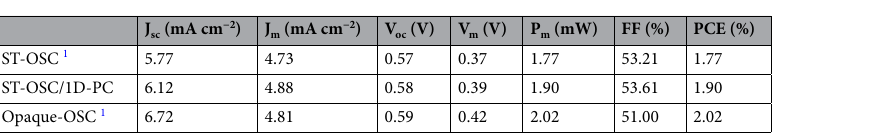
Table 2. Photovoltaic performance of solar